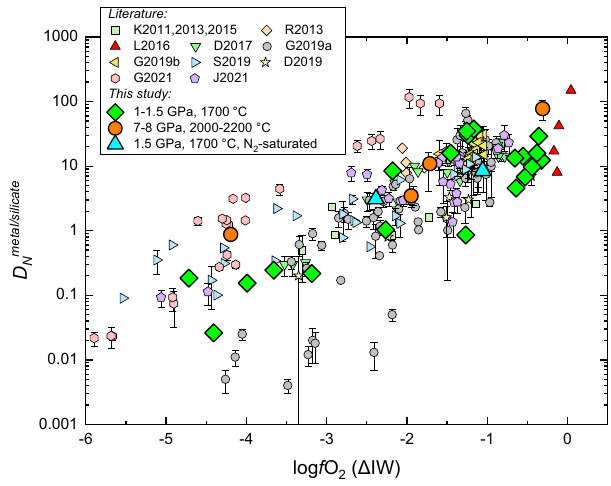
Fig. 2 | Metal/silicate N partition coef fi cients ( D N metal/silicate ) as a function of oxygen fugacity. All D metal = silicate N data were obtained under largely variable condi- tions ( P =0.85 – 26 GPa; T =1523 – 3400K; NBO / T =0.02 – 3.1; and f O 2 =IW – 0.1 to IW – 5.5) and were taken from K2011, 2013, 2015 (refs. 64,92,93), R2013 (ref. 94), L2016 (ref. 35), D2017 (ref. 95), G2019a (ref. 40), G2019b (ref. 18), S2019 (ref. 41), D2019 (ref. 36), G2021(ref. 42),and J2021(ref. 43).The D metal = silicate N are dominantly controlled by f O 2 , and the scatter of D metal = silicate N at a given f O 2 is caused by the variation of other parameters, such as P – T and the compositions of metallic and silicate melts as summarized in Eq. (1). Note that all literature f O 2 values were recalculatedbyusingtheapproachdescribedinMethods.Sourcedataareprovided in Supplementary Data